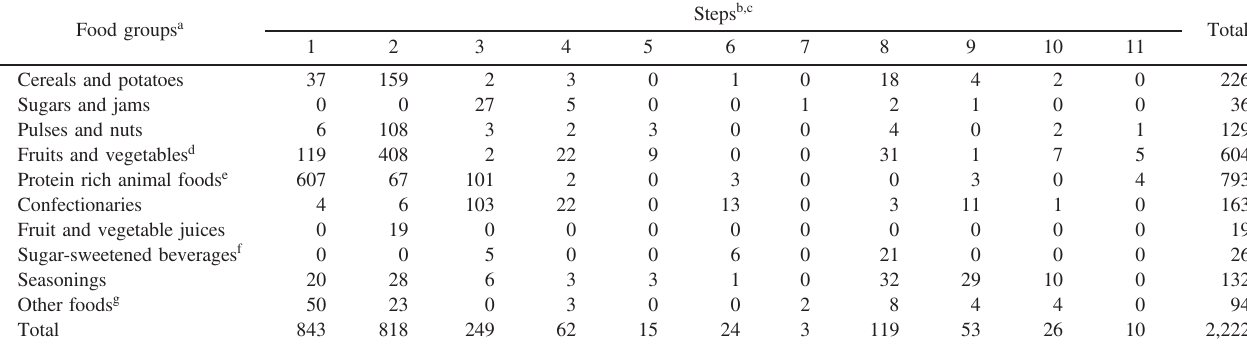
Table 2. Number of food items in each step in the development of added or free sugar database Food groups a Cereals and